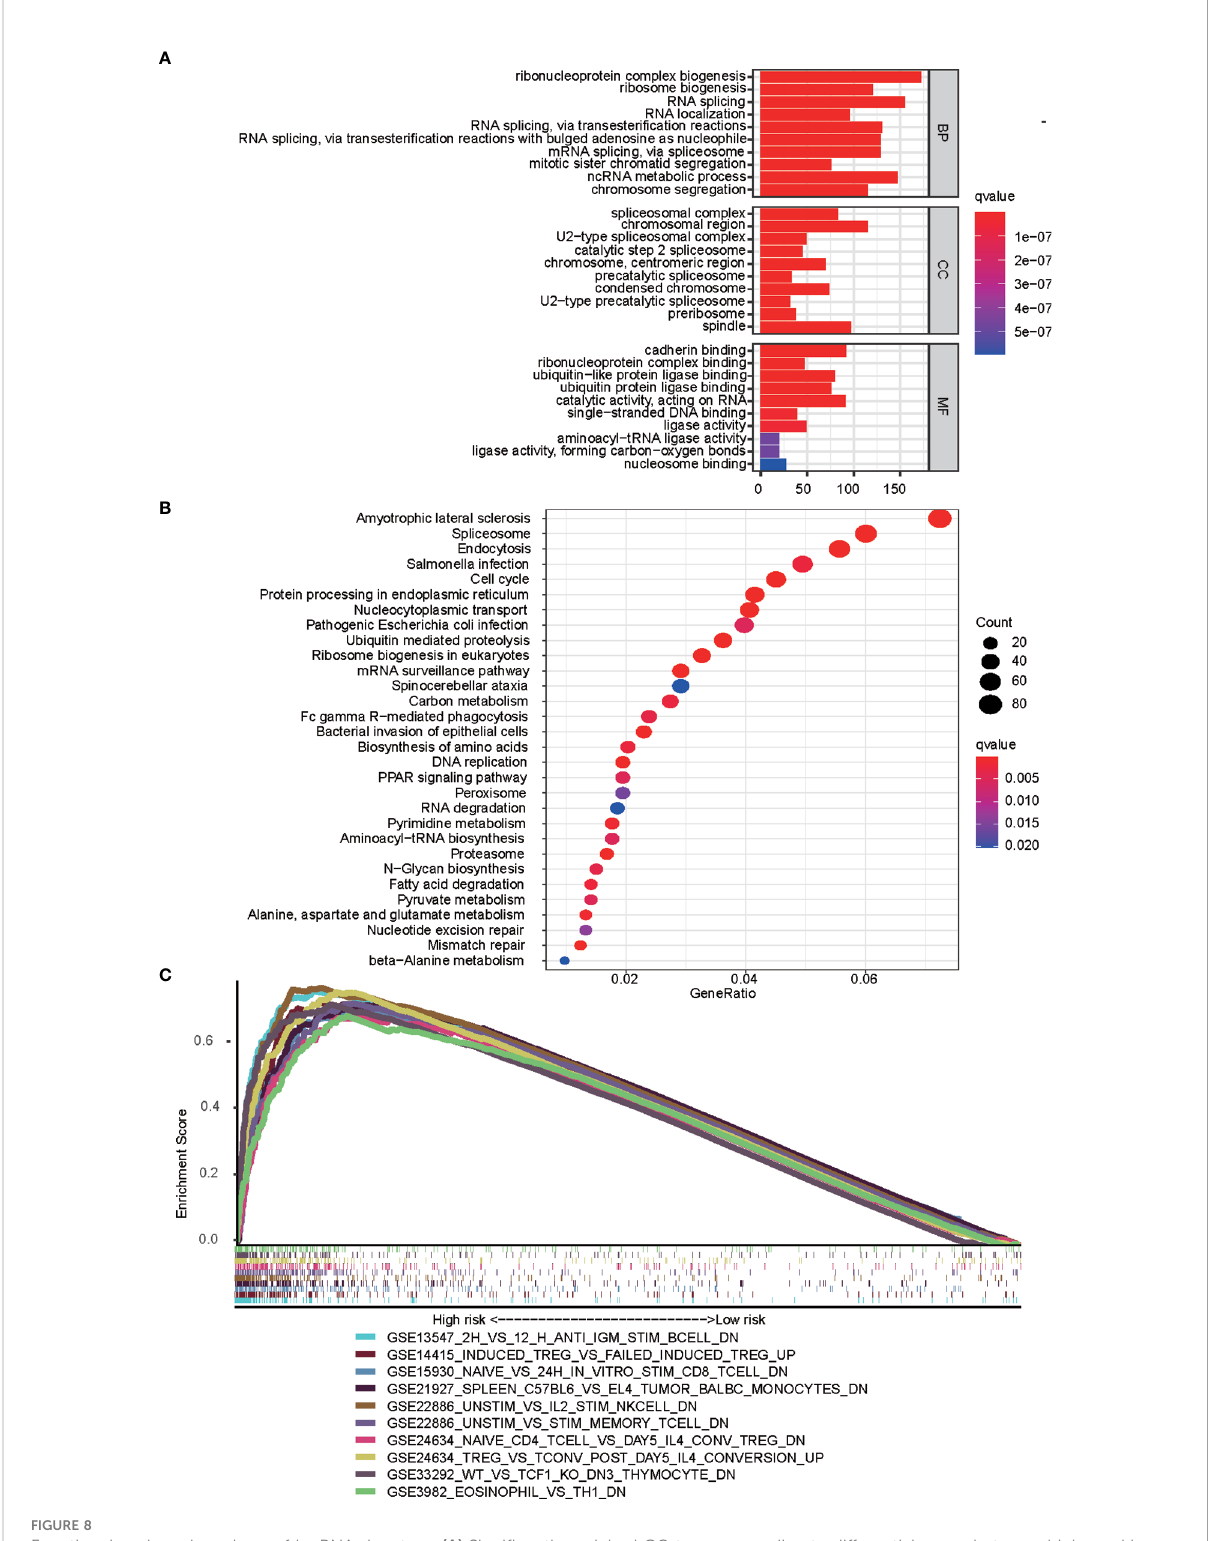
FIGURE 8 Functional analyses based on mfrlncRNA signature. (A) Signi fi cantly enriched GO terms according to differential genes between high- and low- risk populations. (B) Top 30 most enriched KEGG pathways of the common differently genes between high- and low-risk populations (C) GSEA enrichment analysis showing the activation states of biological pathways in high- and low-risk populations. GO, gene ontology; KEGG, Kyoko Encyclopaedia of Genes and Genomes; GSEA, Gene Set Enrichment